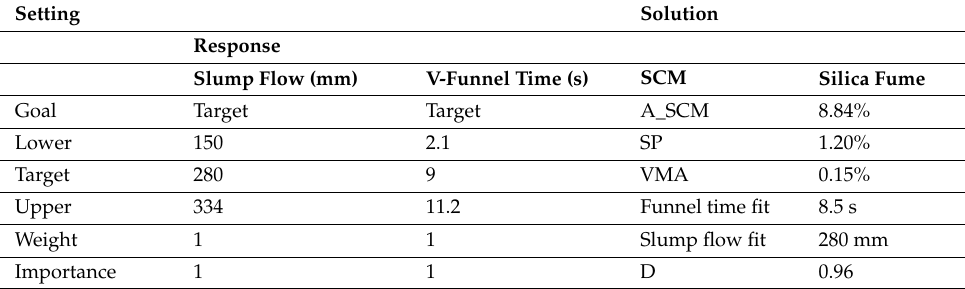
Table 7. Optimized results for slump flow and funnel time.